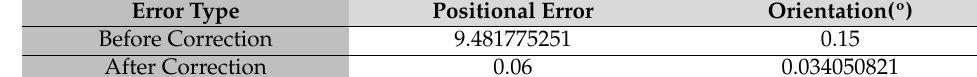
Table 3. Error between desired and measured pose on fourth correction cycle.